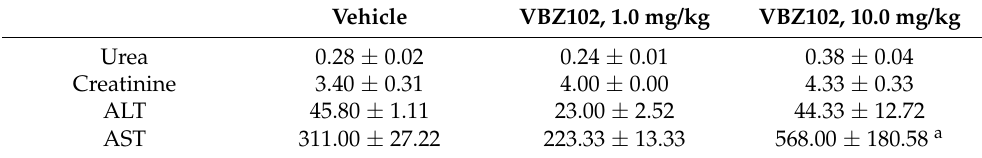
Table 3. Effect of the orally administered VBZ102 on the biochemical parameters of